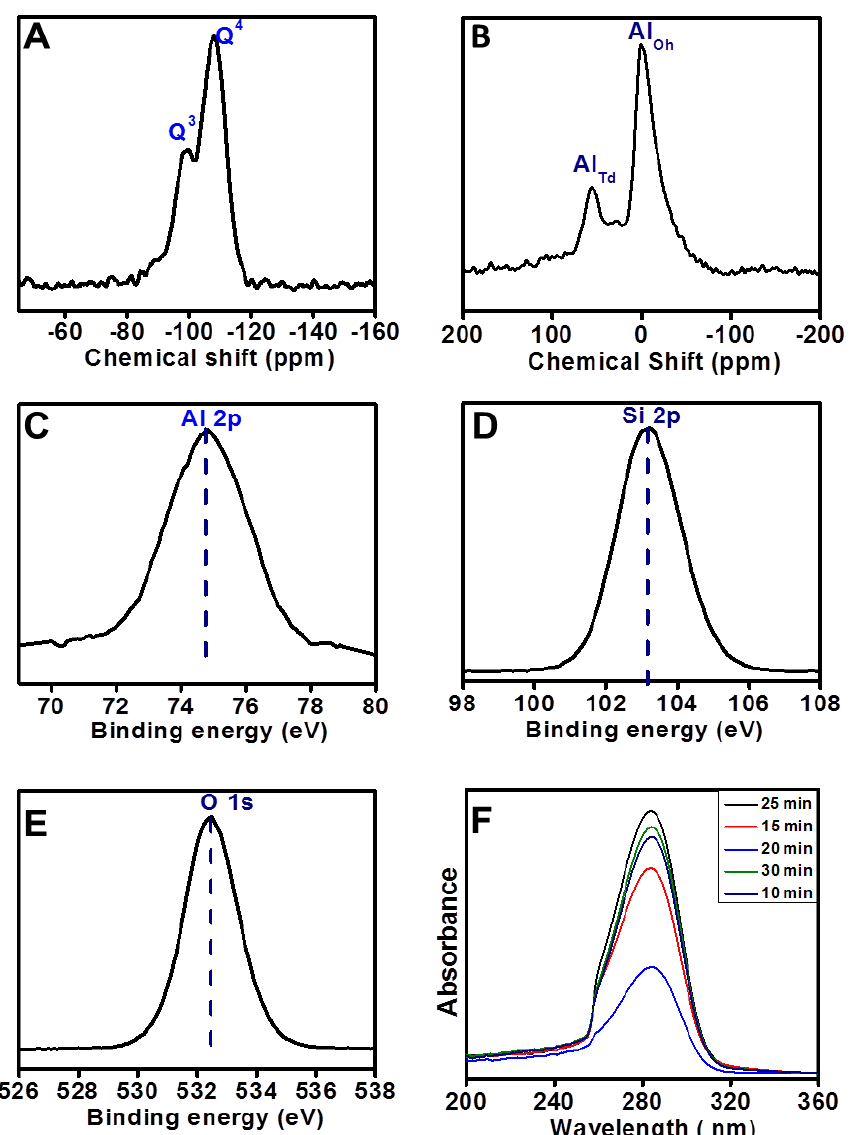
Figure 4 . ( A ) Solid-state 29 Si NMR spectroscopic analysis of PHMS−1 . ( B ) Solid-state 27 Al NMR spec- Figure 4. ( A ) Solid-state 29 Si NMR spectroscopic analysis of PHMS-1. ( B ) Solid-state 27 Al NMR troscopic analysis of PHMS−2 and XPS analysis for Al 2p, ( C ) Si 2p, and ( D ) O 1s ( E ) in PHMS−2 . ( F ) spectroscopic analysis of PHMS-2 and XPS analysis for Al 2p, ( C ) Si 2p, and ( D ) O 1s ( E ) in PHMS-2. Time-dependent UV-Vis spectrum of HMF formation from fructose . ( F ) Time-dependent UV-Vis spectrum of HMF formation from